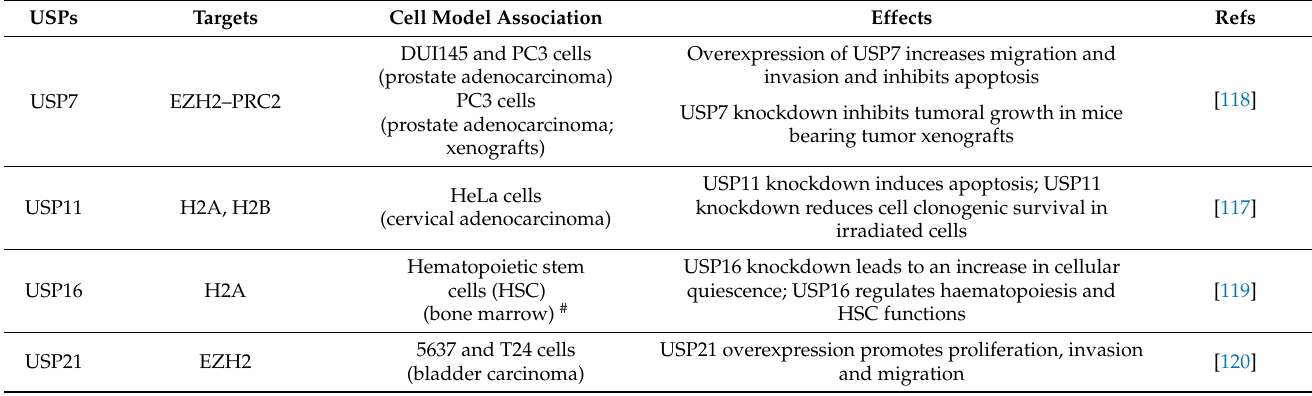
Table 3. Summary of cellular consequences resulting from interactions between different USPs and target proteins associated with chromatin